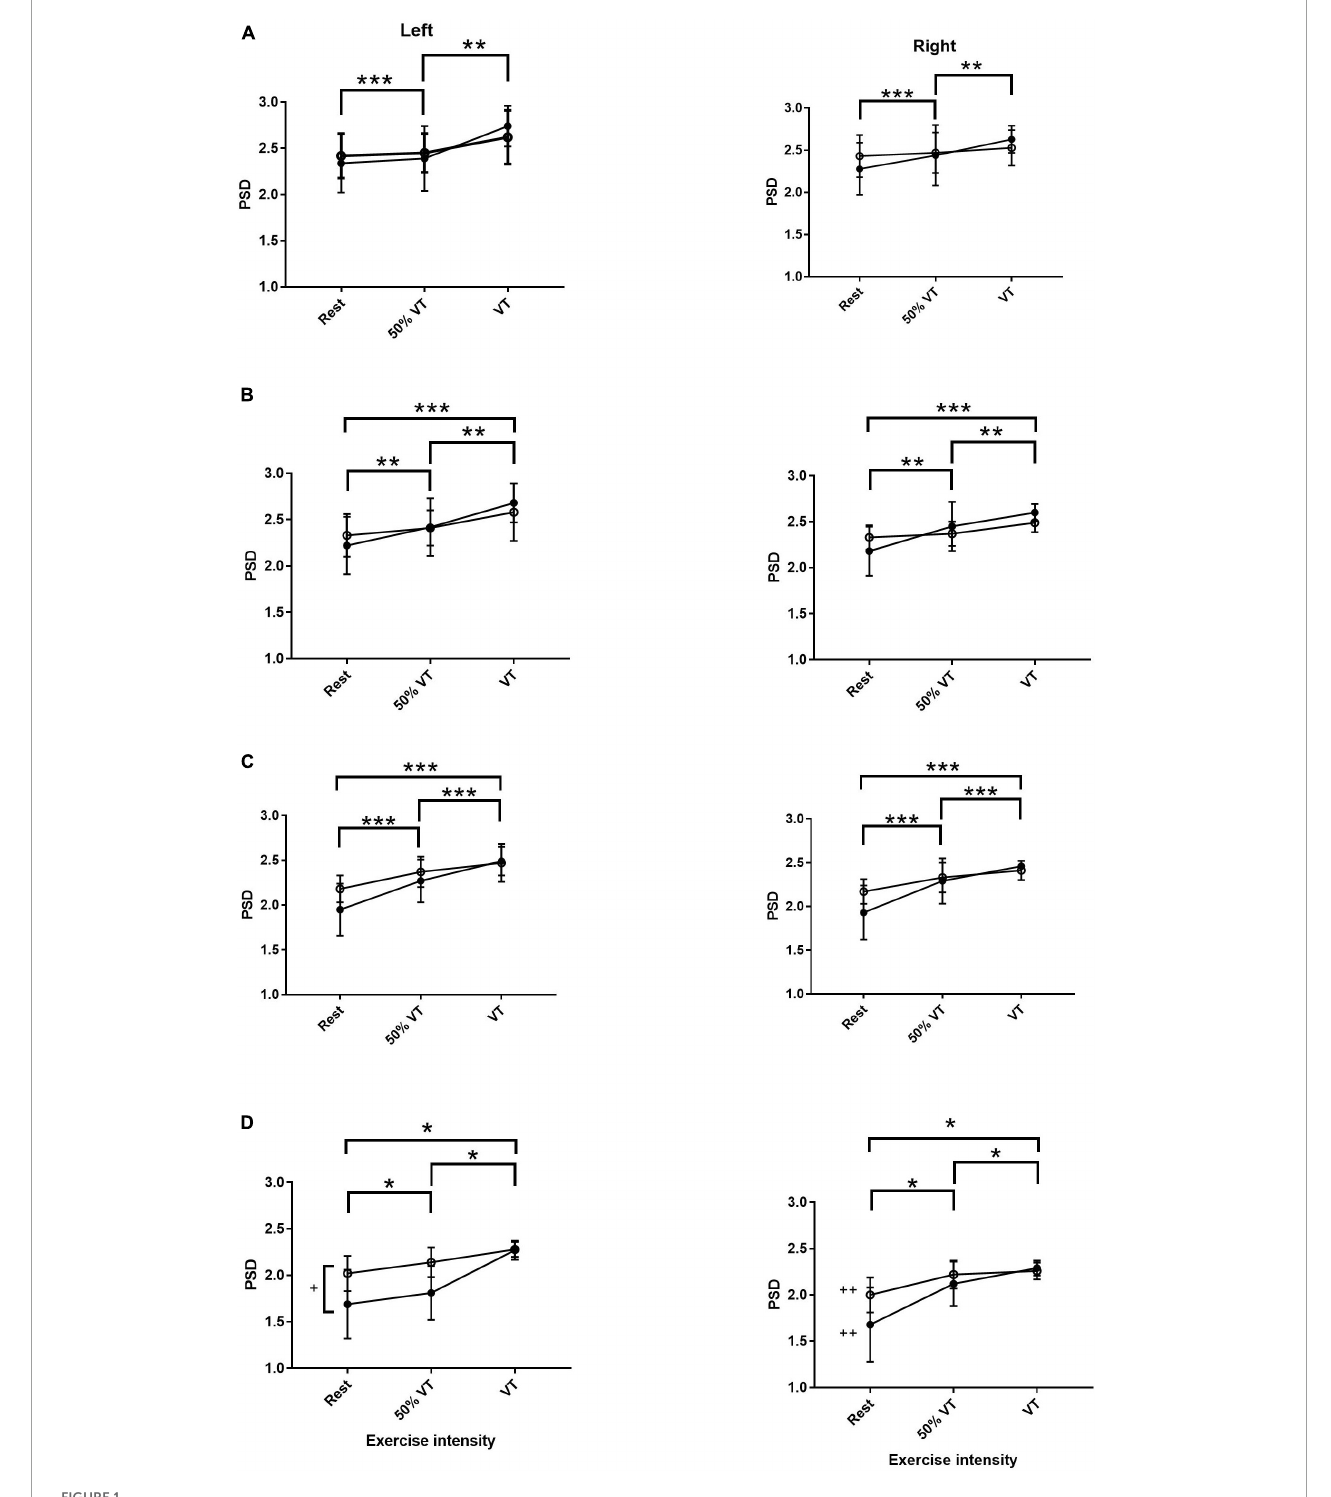
FIGURE1 Power spectral density (PSD) responses in alpha slow (A) , alpha fast (B) , beta (C) , and gamma (D) within the prefrontal cortex in AH ( • ) and MI ( (cid:78) ) in the left and right hand sides. Significant differences across intensities; * P < 0.05, ** P < 0.01, *** P < 0.001. + significant differences between groups ( P < 0.05) and ++ significant differences between gamma left AH and MI ( P < 0.05).